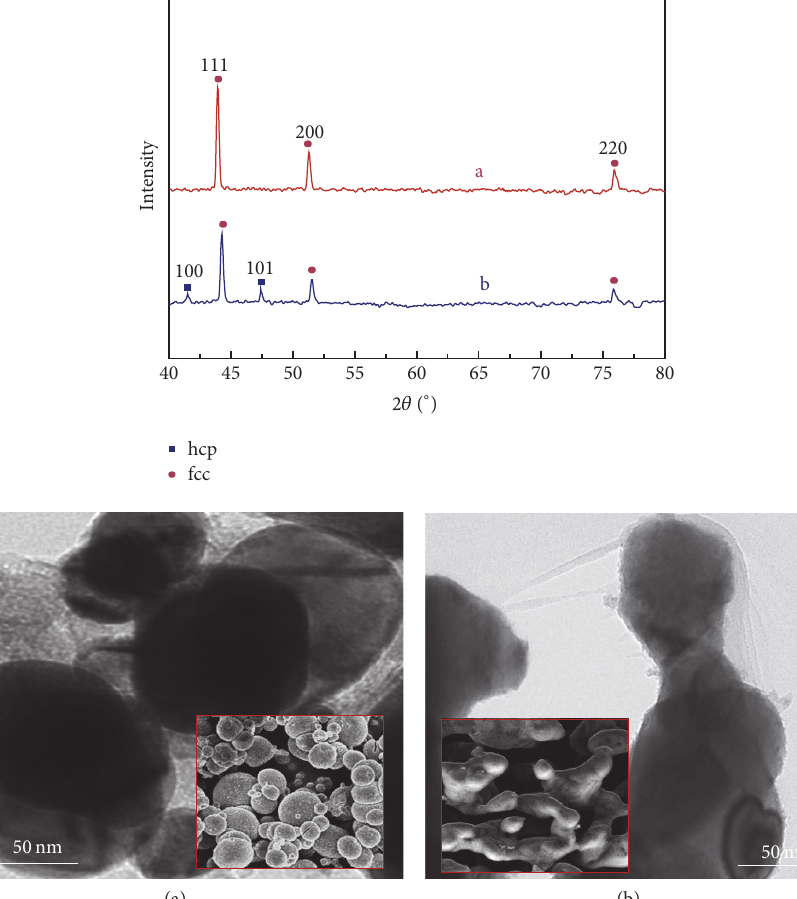
Figure12:XRDandTEMimagesforCo(decomposedat450 ∘ C):(a)sample(a)mechanicalsolid-statereaction;(b)sample(b)hand-grinding.